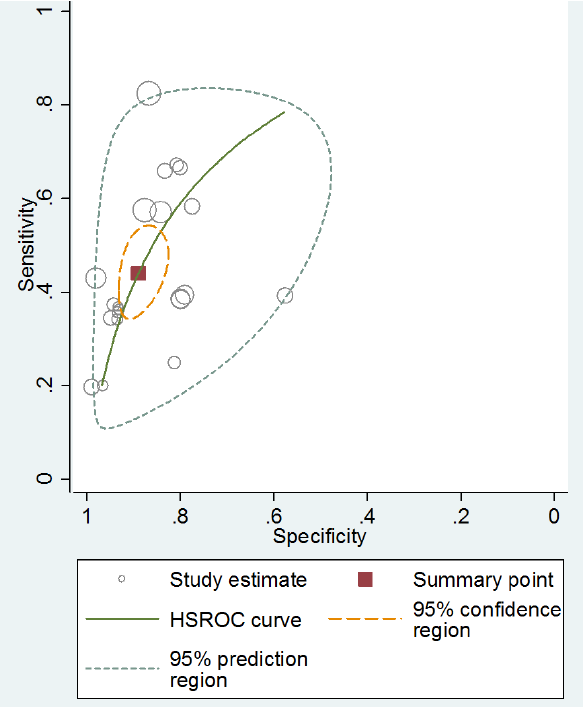
Figure 7: Combined DOR for serum CA72-4 in the diagnosis of colo- rectal